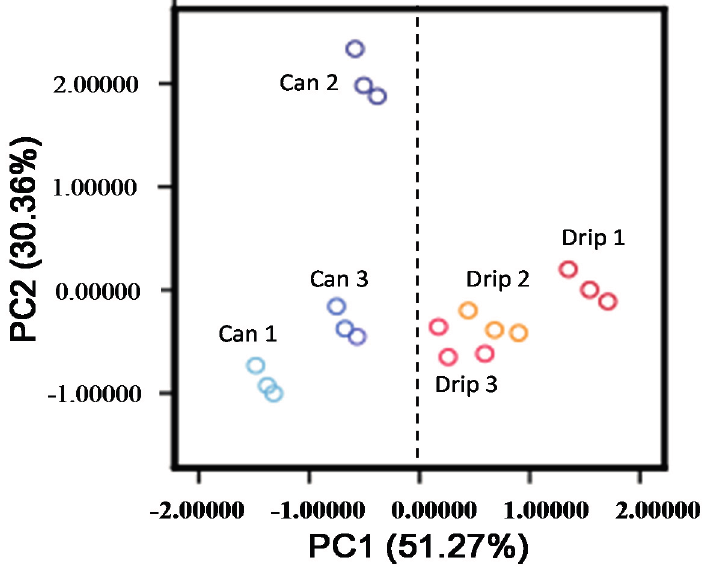
Figure 1. PCA of electronic resistances of drip and canned coffees ( n =